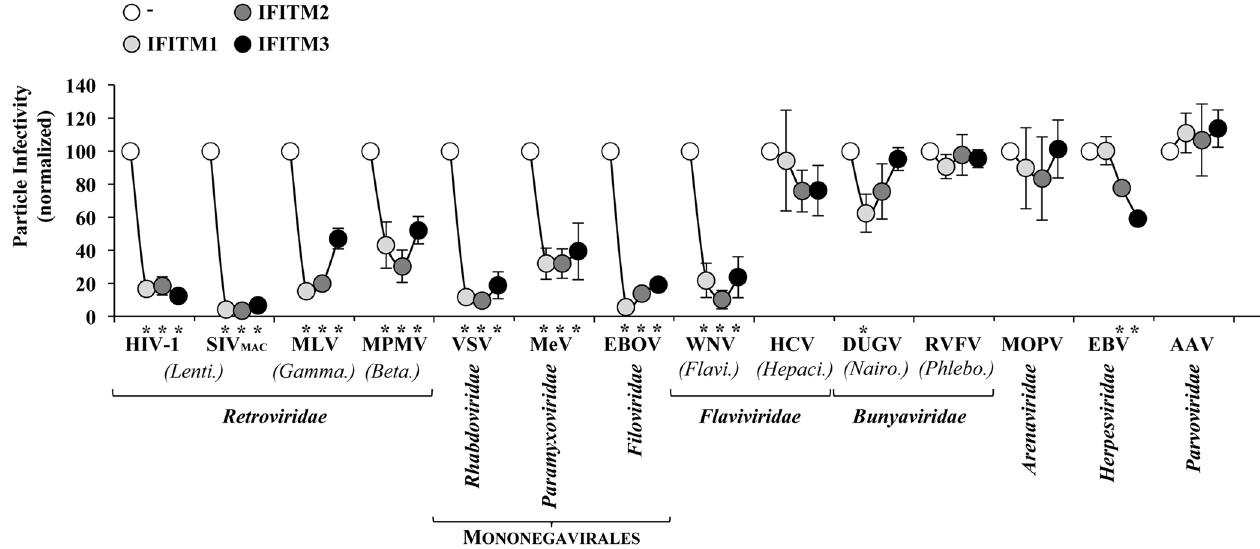
Fig 4. Effect of IFITMs on the production of fully infectious viral particles. Normalized amounts of virion particlesproducedin the presenceof absenceof IFITMs were used to challengetarget cells prior to analysisof their intrinsicinfectivity by FACS, FFA or TCID50, accordingto the specific virus and as presented in SupplementalS1 Fig. For each virus, infectivity has been normalizedto control viruses producedin the absence of IFITMs. The graph presents averagesand SEM of 3 to 6 independent experiments. * , statistically significantupon a Student t test, p (cid:20) 0.05.